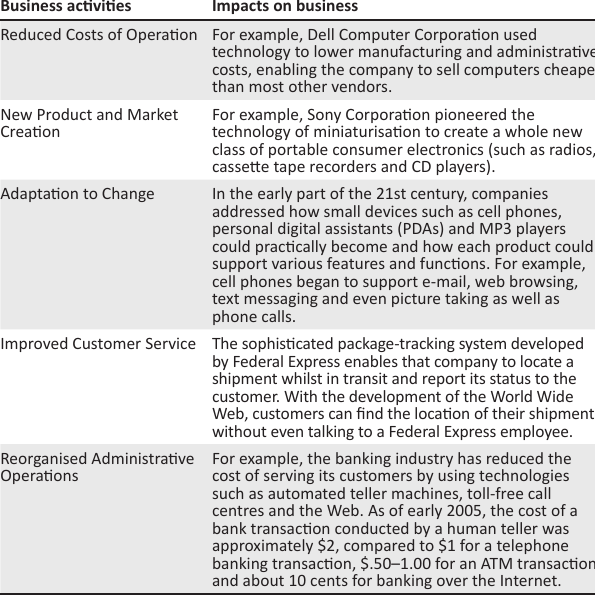
TABLE 1 : Impacts of technologies on business